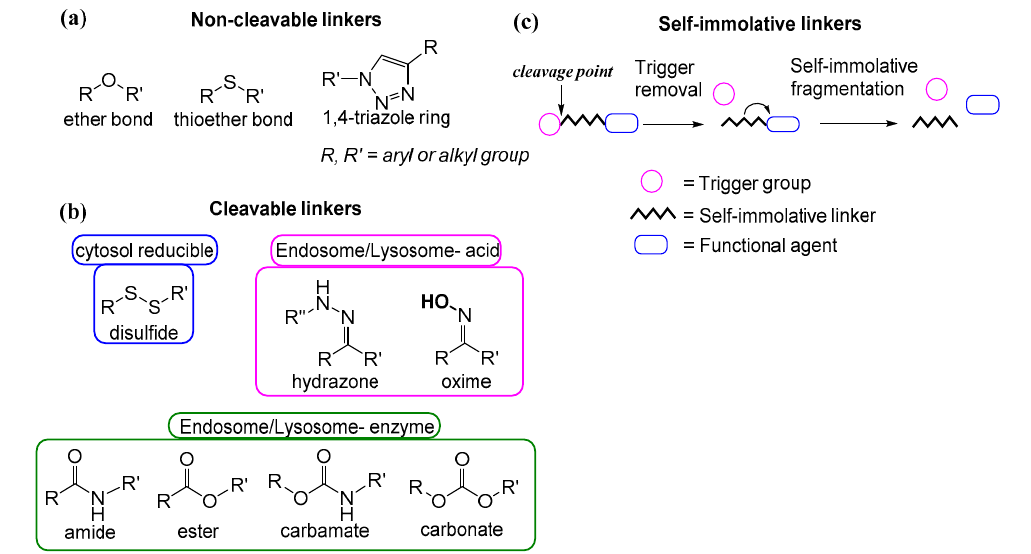
Figure 7. Categorization of linkers utilized in theranostic agents: ( a ) non ‐ cleavable linkers, ( b ) cleavable linkers, ( c ) self ‐ immolative linkers.